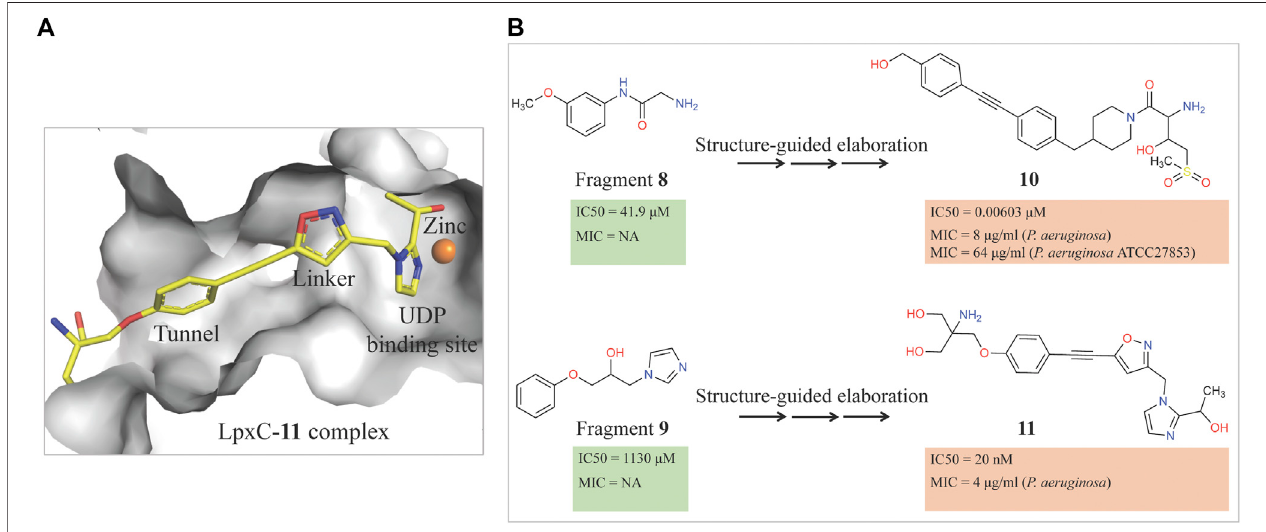
FIGURE 2 | (A) Location of compound 11 [2-(1S-hydroxyethyl)-imidazole] in the Pa LpxC- 11 complex structure (pdb id 7ci9) determined by X-ray crystallography (Yamada et al., 2020). The protein binding site is represented as grey surface and the compound as stick. The zinc ion is shown as an orange sphere. (B) Structure- guided elaboration of fragments 8 and 9 , leading to compounds 10 and 11 , respectively with enhanced potencies and inhibition